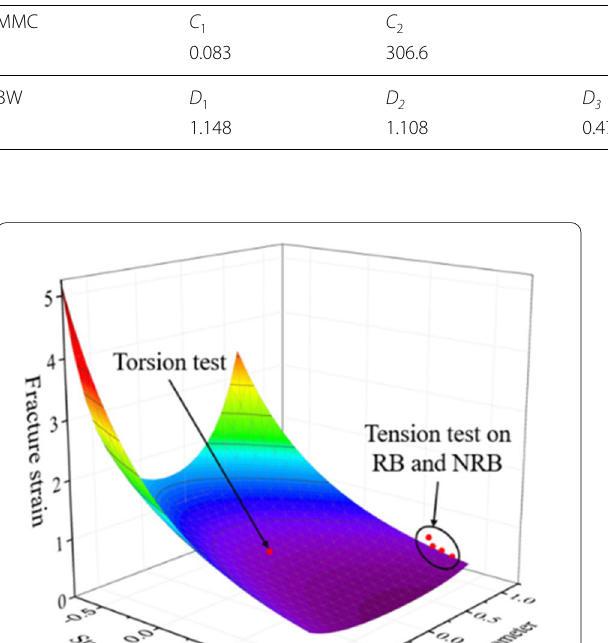
Figure 15 Comparison of prediction errors between the BW and the